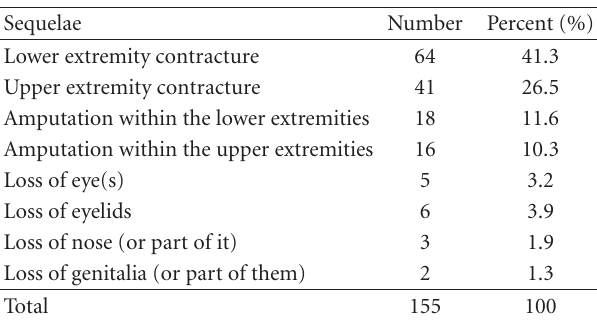
Table 1: Sequelae of Buruli